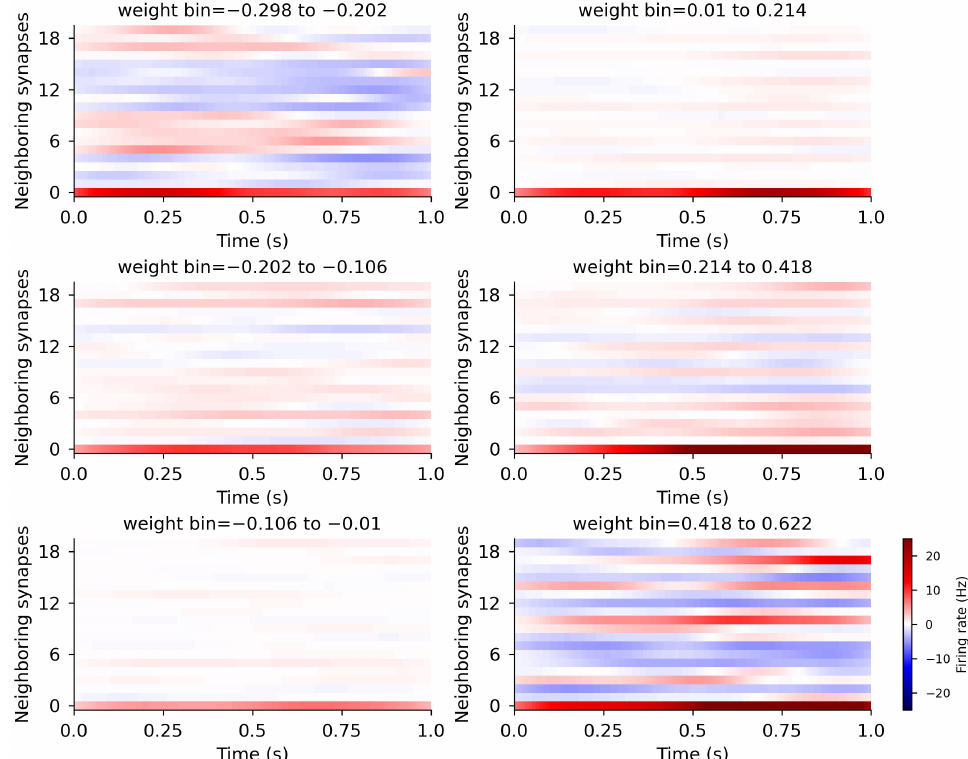
Figure 8. Activity of neighboring synapses influences magnitude of plasticity. spatiotemporal firing patterns produce different effects on the magnitude of synaptic plasticity. Each panel shows the mean subtracted instantaneous firing rate following a trial for a different weight change bin. Neighboring synapses 1–19 (y-axis) shows firing rate (color coded) versus time (x-axis) of 19 nearest neighbors to synapse 0. Synapses with small changes in weight have neighbors that receive average input firing rates. Synapses with intermediate to high weight changes have a few neighbors with higher than average input firing